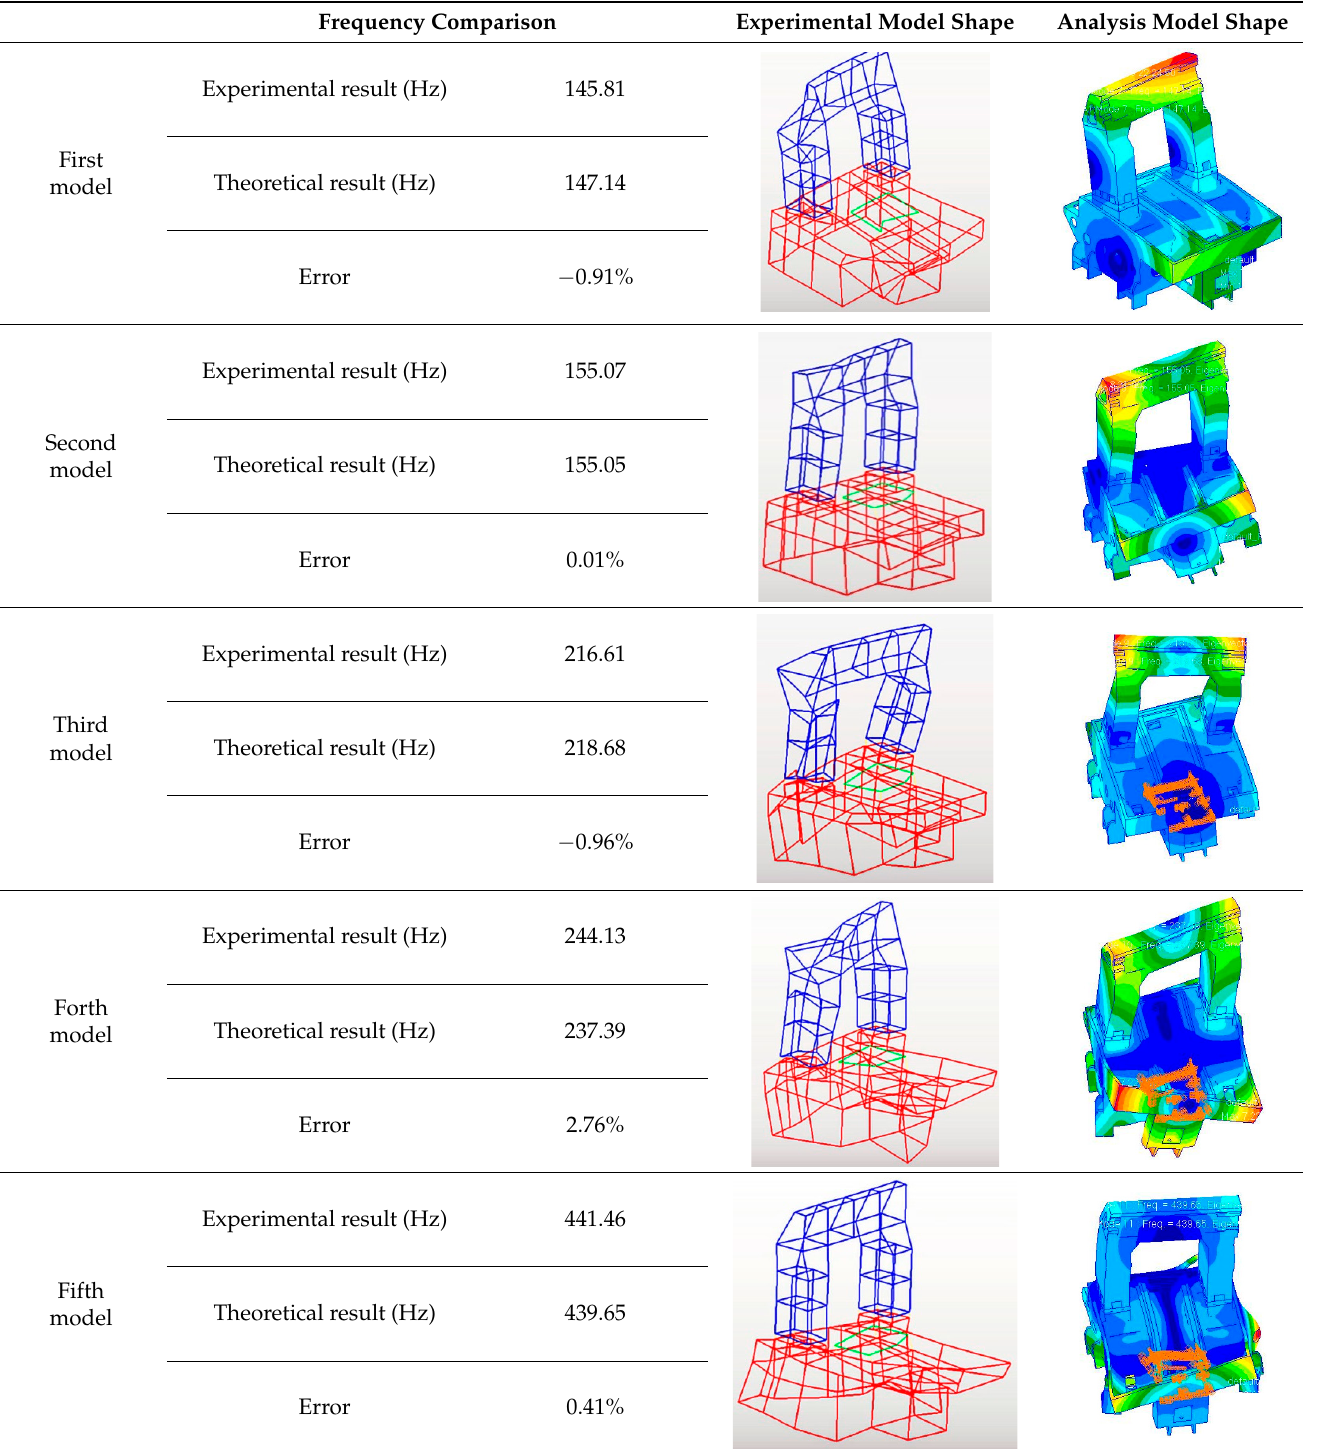
Table 12. Result of the theoretical analysis and modal experiment.